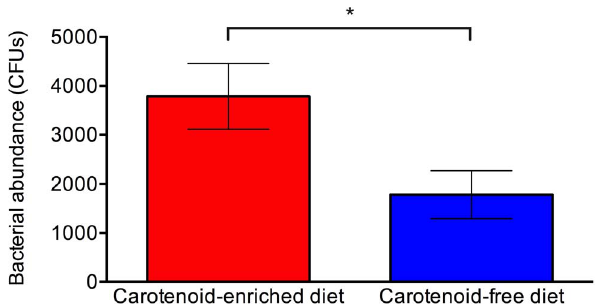
Figure 1. Species richness (number of different bacterial morphotypes isolated from each individual) of the culturable bacterial community associated with the skin of Agalychnis callidryas fed a carotenoid-enriched and carotenoid-free diet. Error bars show 6 1 S.E.M. An *indicates a significant difference.